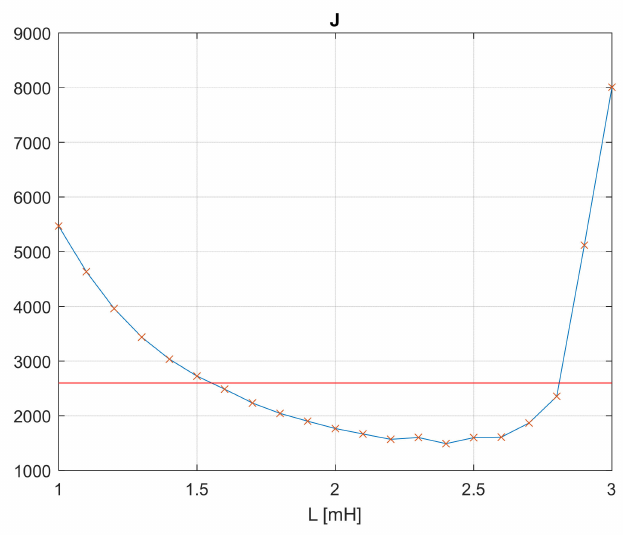
Figure 14. Penalty function vs. parameter L of the KKT